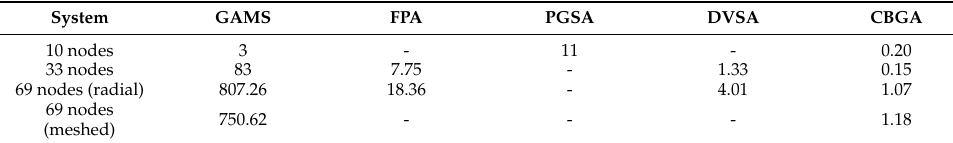
Table 12. Run time for the test systems (s).